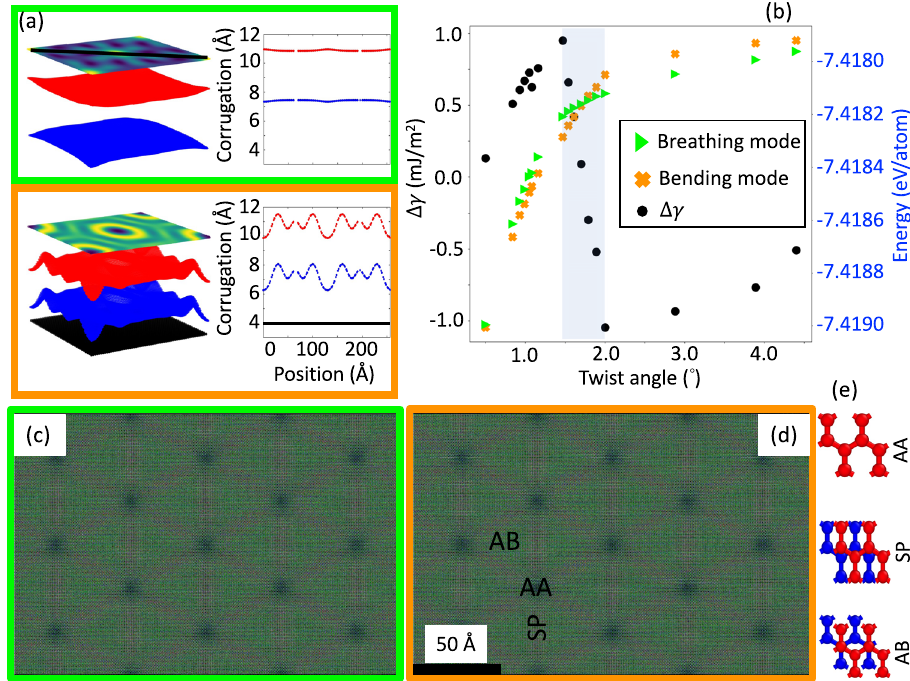
Fig. 1 Corrugation in magic-angle twisted bilayer graphene (tBLG). a The 3D view (left) of the atomic structure and the pro fi le of the out-of-plane displacement of magic-angle tBLG in the breathing mode (green box) and the bending mode (orange box). A 2D projection of the corrugation of the top layer of the tBLG is also shown by a color plot. The pro fi le of the displacement (right) is obtained by the scan of atomic height along the diagonal of tBLG as shown by the black line in the breathing mode. b Energy density difference between the breathing and bending modes and the total energy per atom of the breathing and bending mode tBLG with reference to the AB bilayer graphene of the same area as a function of twist angle, showing the thermodynamic favorability of the bending mode at low twist angles ( θ ≤ 1.61 ∘ ). c , d The top view of tBLG in the breathing and the bending modes respectively, showing similar moiré patterns with six-fold symmetry. The region of AA, SP and AB are identi fi ed. e Representation of the AA, SP and AB stackings of